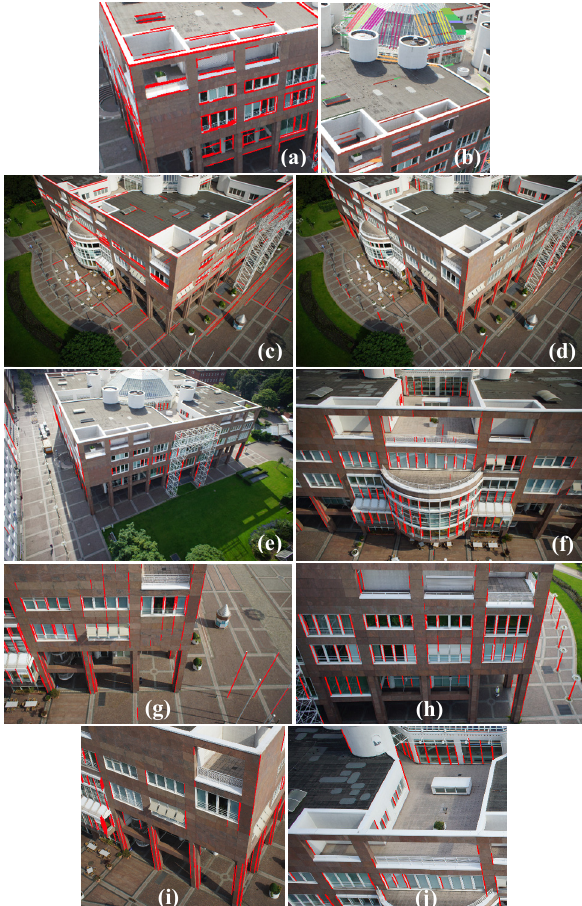
Figure 6. Results from the nadir point detection procedure; (a) line segments, (b) parallel line segments in different color based on their direction, (c) horizontal segments used for the detection of the true horizon line, (d)-(j) vertical segments used for the nadir point